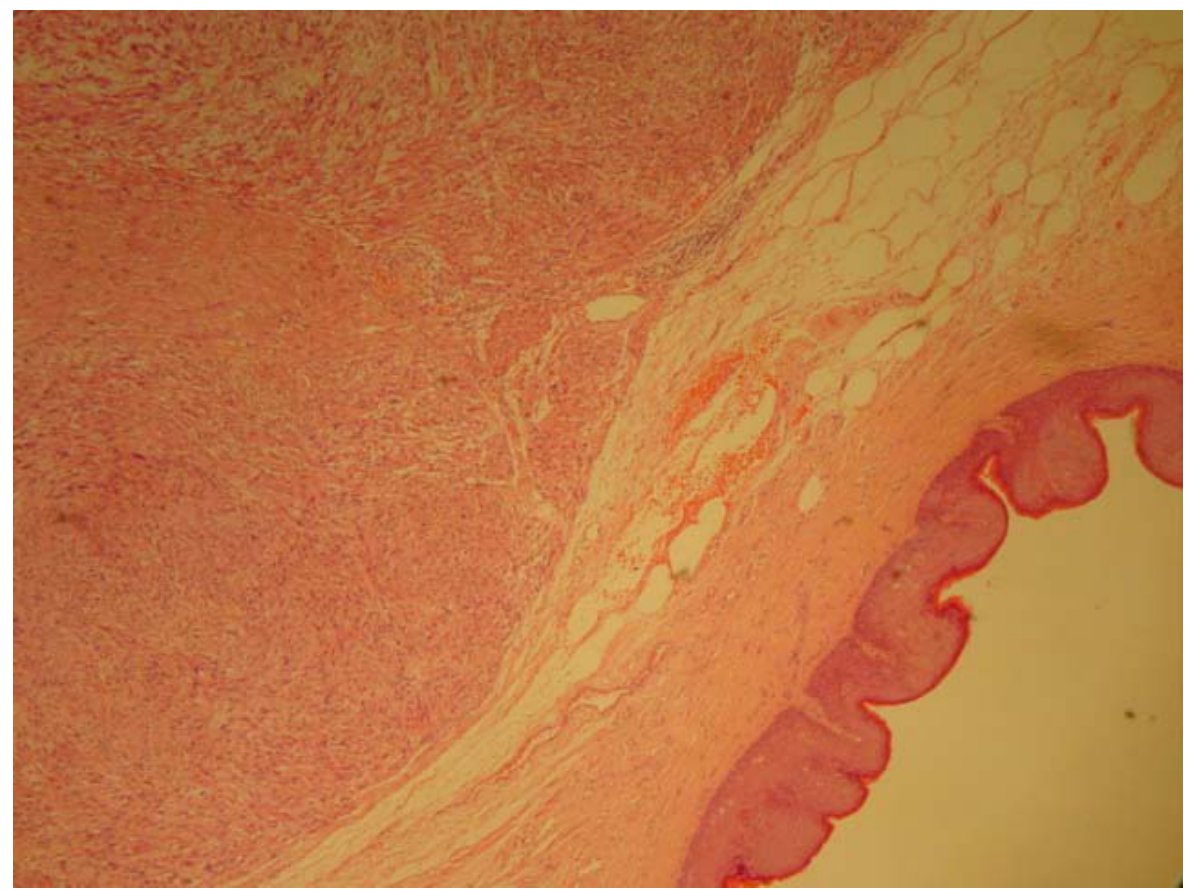
FIGURE 1. H + E stain of tissue